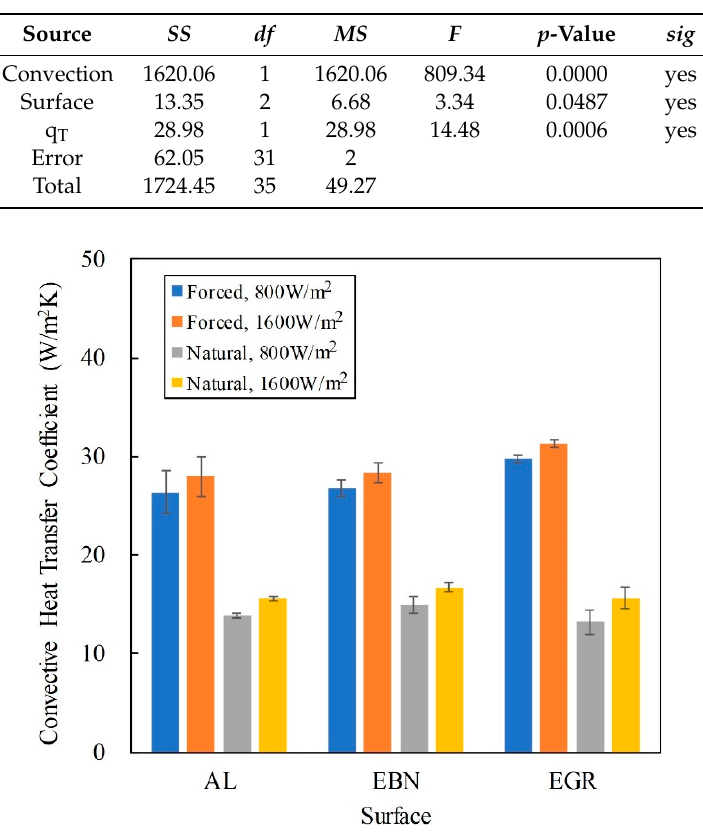
Figure 8. Effect of surface type on the convective heat transfer coefficient. Figure 8. E ff ect of surface type on the convective heat transfer coe ffi